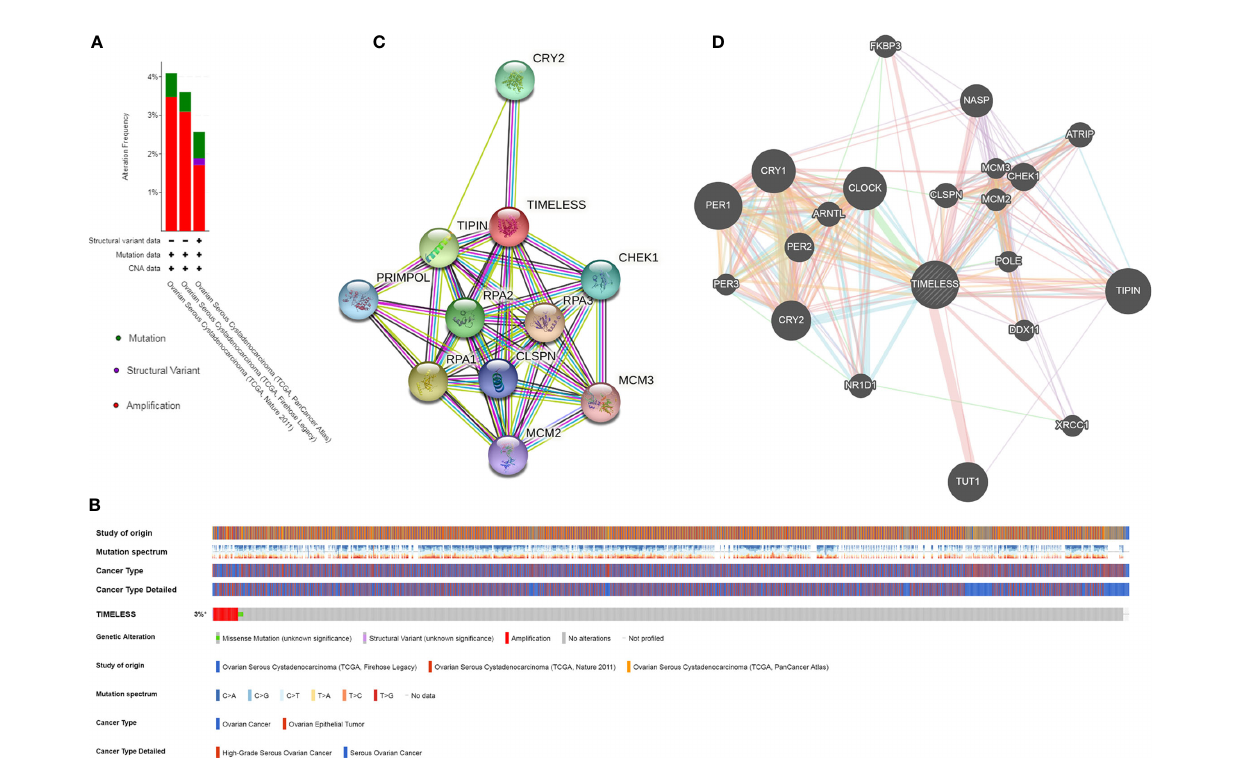
FIGURE 3 | TIM gene mutation and expression analysis in OV. (A, B) The expression and mutation analysis of TIM in OV. TIM was altered in 51 samples (3%) of the total 1,680 patients with OV. (C) The protein-protein network of TIM was shown by STRING. (D) The protein interaction network for TIM using GeneMANIA. *p <